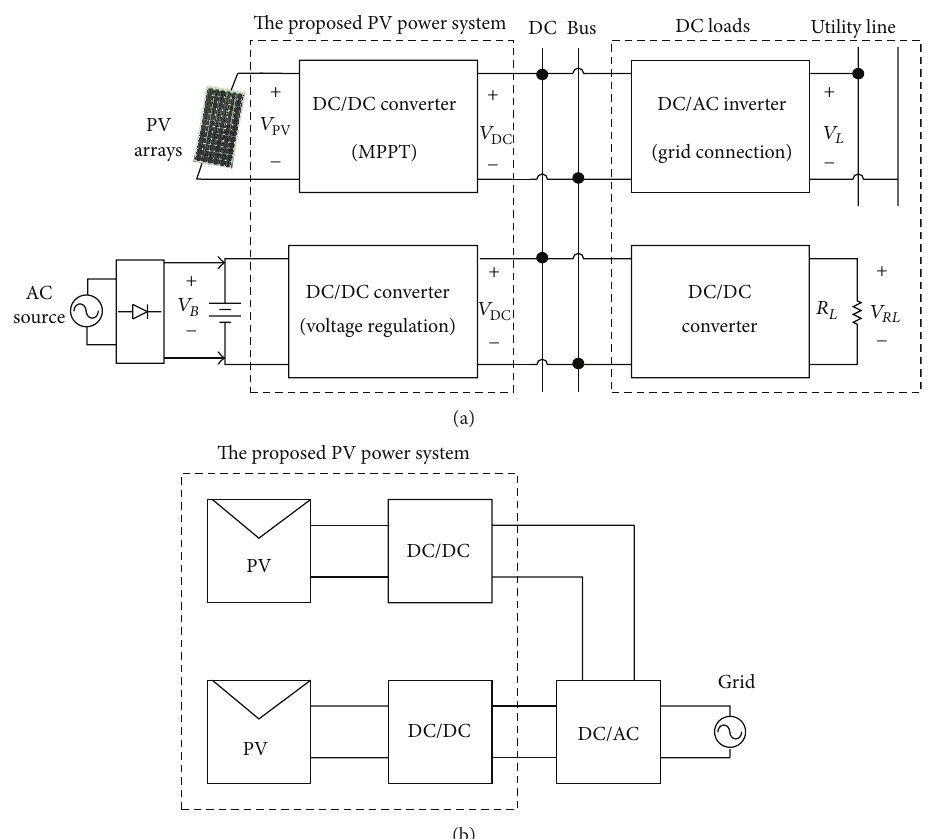
Figure 1: Block diagram of PV power conversion system for (a) DC load applications and (b) grid connection.